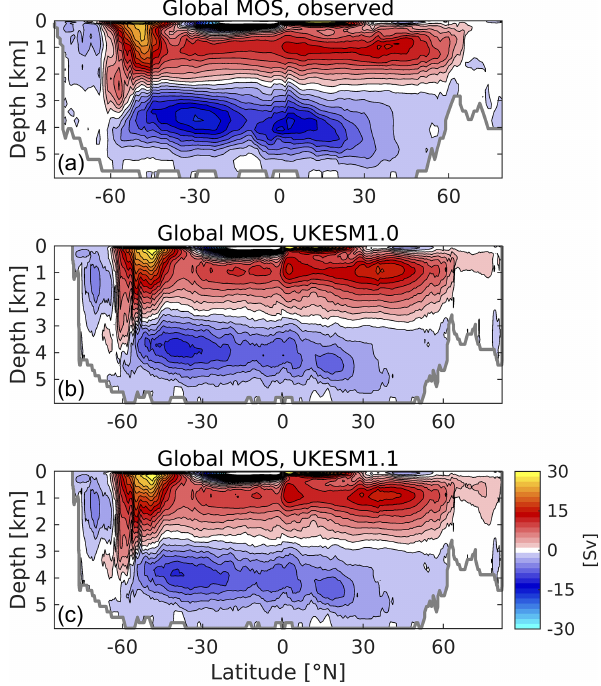
Figure 12. Observationally derived (a) and UKESM1 (b) and UKESM1.1 (c) meridional overturning circulation (MOC) for the global ocean. The observational circulation is derived from the Esti- mating the Circulation and Climate of the Ocean (ECCO) V4r4 cir- culation reanalysis for the period 1992–2017. The model circulation shown is based on the decadal mean streamfunction for the period 2000–2009, averaged across the members of both model ensembles. Both plots include the components from parameterised mesoscaled eddies (Gent and McWilliams, 1990; Gent et al., 1995). MOC is in sieverts with a contour interval of